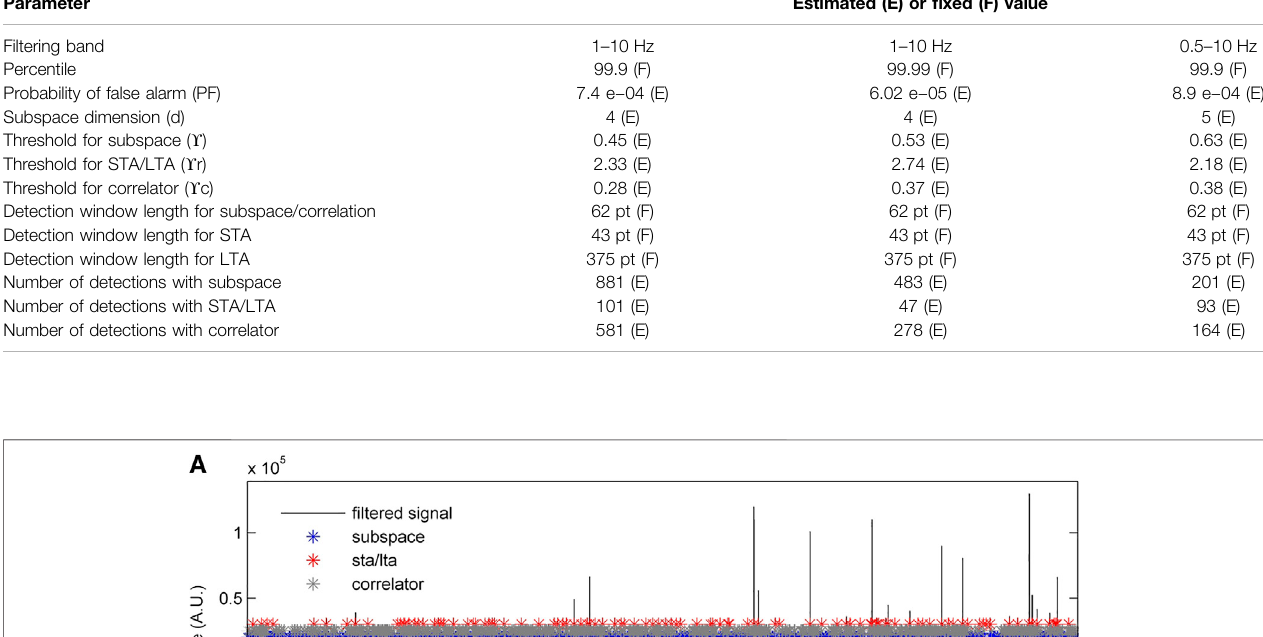
Frontiers in Earth Science |